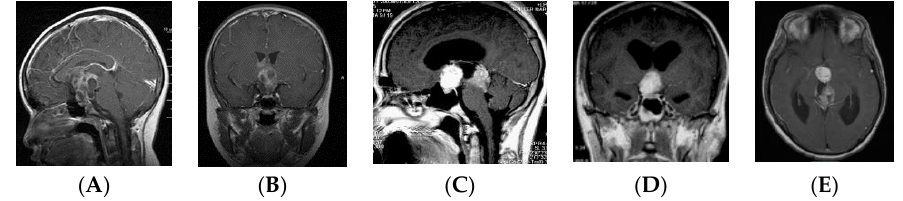
Figure 2. Type Ib. Post-contrast MR, sagittal ( A ) and coronal ( B ) views of a patient with S-GCT and post-contrast MR, sagittal ( C ), coronal ( D ) and axial ( E ) views of a patient with bifocal GCT. The pituitary stalk is not visualized but the pituitary gland is preserved. Note the subependymal infiltrate of at the III ventricle wall ( E ).